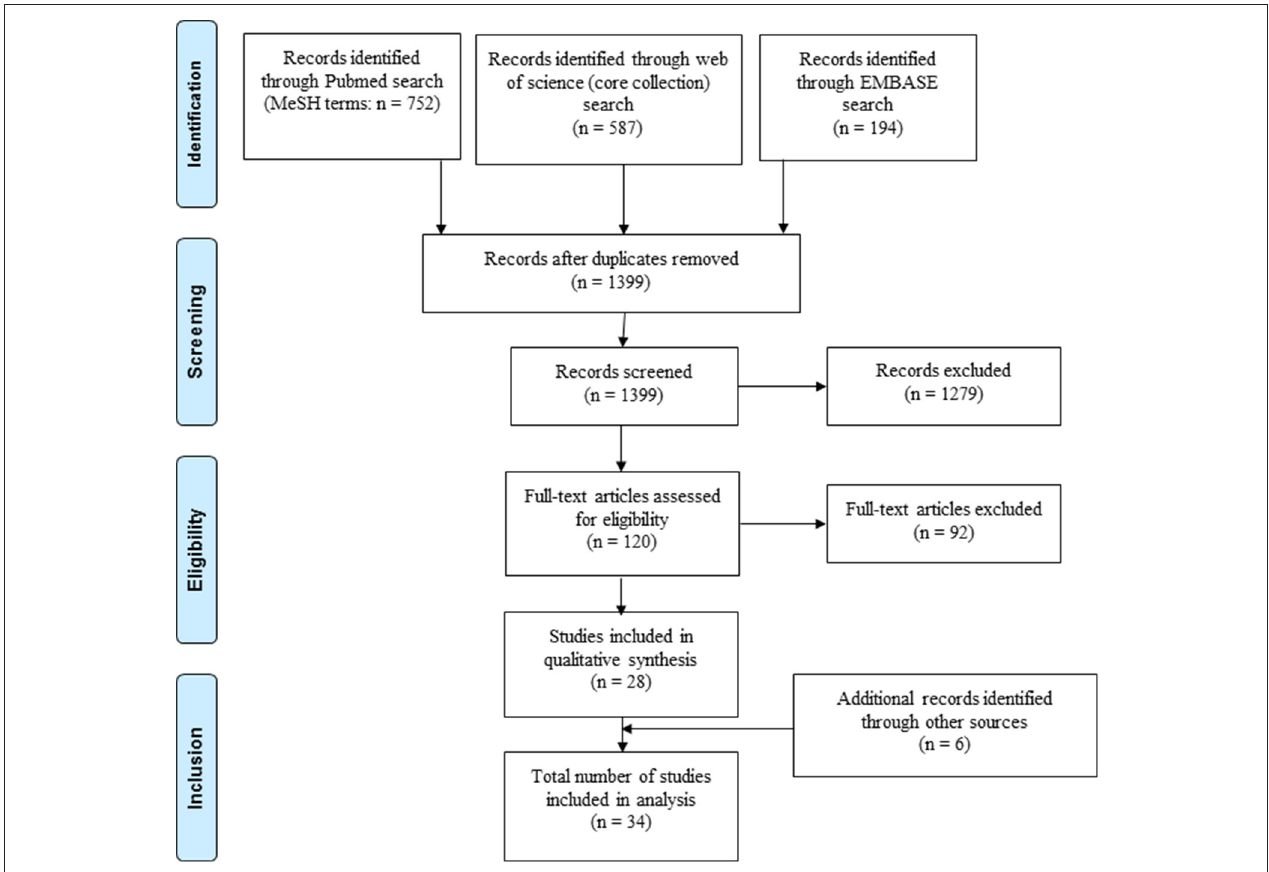
FIGURE 1 | Selection of articles included in the